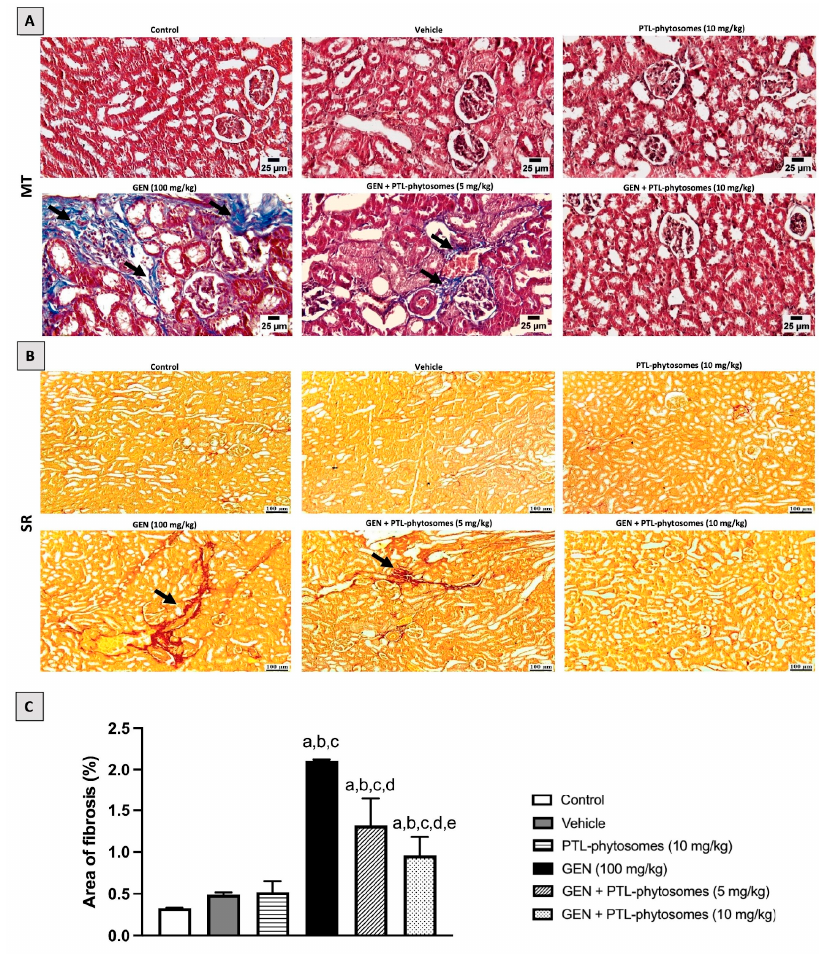
Figure 5. PTL-phytosomes alleviated GEN-induced kidney fibrosis. Photomicrographs of kidney sections stained with MT and SR stains to double confirm interstitial fibrosis. ( A , B ) In the MT- and SR-stained sections, GEN caused collagen deposition in the renal parenchyma (black arrows), char- acteristic of interstitial fibrosis. In contrast, treating with PTL-phytosomes (5 mg/kg) with GEN showed minimal collagen deposition. Moreover, PTL-phytosomes (10 mg/kg) + GEN co-administra- tion showed a normal histological picture of the renal parenchyma. Scale bars, 25 and 100 μ m. ( C ) Semi-quantitative assessment of renal fibrosis area. Data are expressed as Mean ± SD ( n = 6). a: sig- nificant when compared to control at p < 0.05; b: significant when compared to vehicle at p < 0.05; c: significant when compared to PTL-phytosomes at p < 0.05; d: significant when compared to (GEN)- alone at p < 0.05; e: significant when compared to GEN + PTL-phytosomes (5 mg/kg) at p < 0.05.